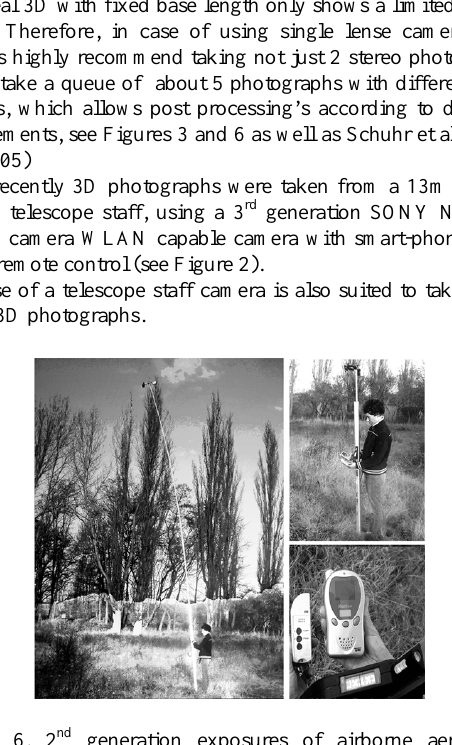
Figure 6. 2 nd generation exposures of airborne aerial